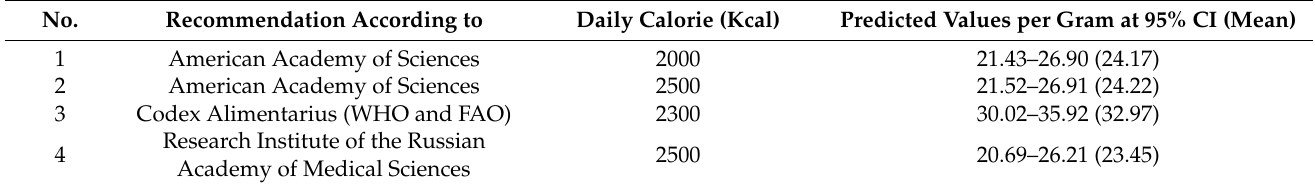
Table 5. ARP values predicted by the ANN per gram of dry matter according to recommended daily human requirements taken from the Codex Alimentarius and recommendations according to Russian and American Academies of Sciences, WHO and FAO